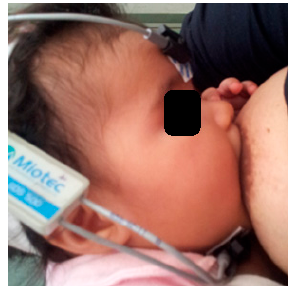
Figure 2. Electromyographic evaluation. Electrodes attached to the bone (forehead) and submandibular (suprahyoid muscles) regions during sucking in breastfeeding.